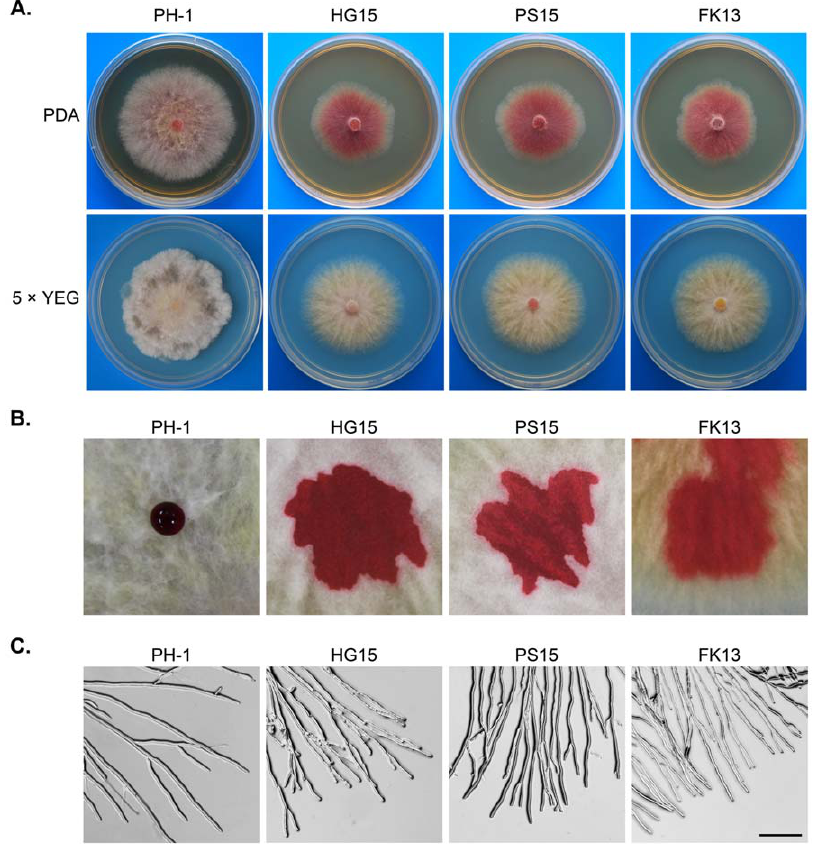
Figure 1. Growth defects of the Fghog1 , Fgpbs2 , and Fgssk2 mutants. A . Colonies of the wild type (PH-1) and the Fghog1 (HG15), Fgpbs2 (PS15), and Fgssk2 (FK13) mutants grown on PDA and 5xYEG agar plates for 3 days. B . Colony surface hydrophobicity tests with the same set of mutants. Photos were taken 15 min. after placing droplets of 50 m l red ink on the surface of the wild-type and mutant colonies. C . Hyphal tip growth and branching patterns of PH-1 and the same set of mutants on PDA plates. The branching angles were reduced in the extension zone of mutant colonies. Bar=150 m m.